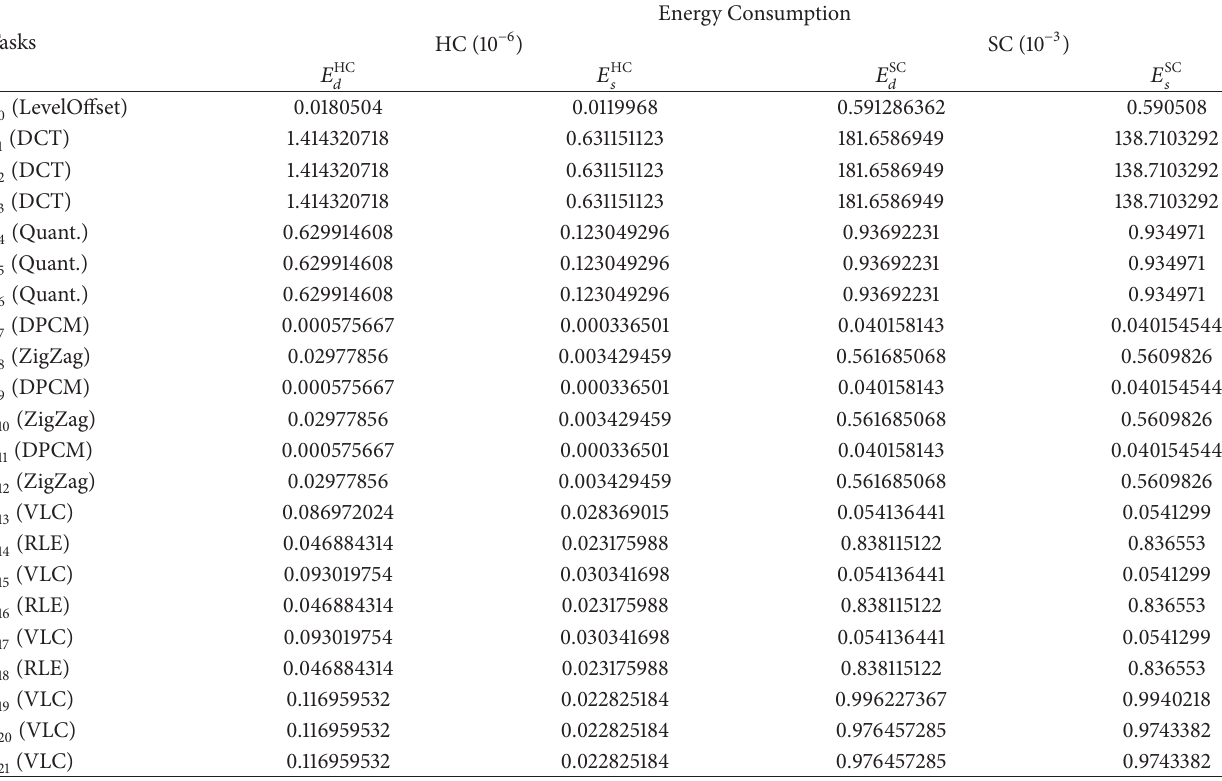
Table 4: Energy consumption of HT.